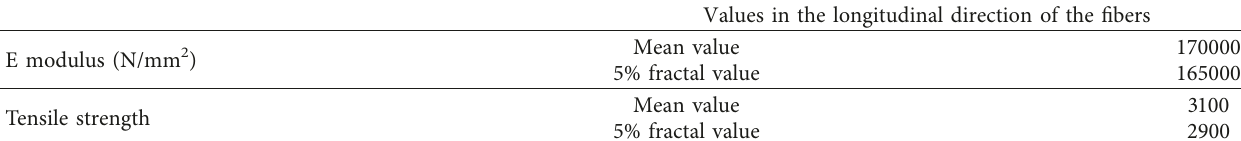
Table 4: Mechanical/physical properties of CFRP laminates ∗ .